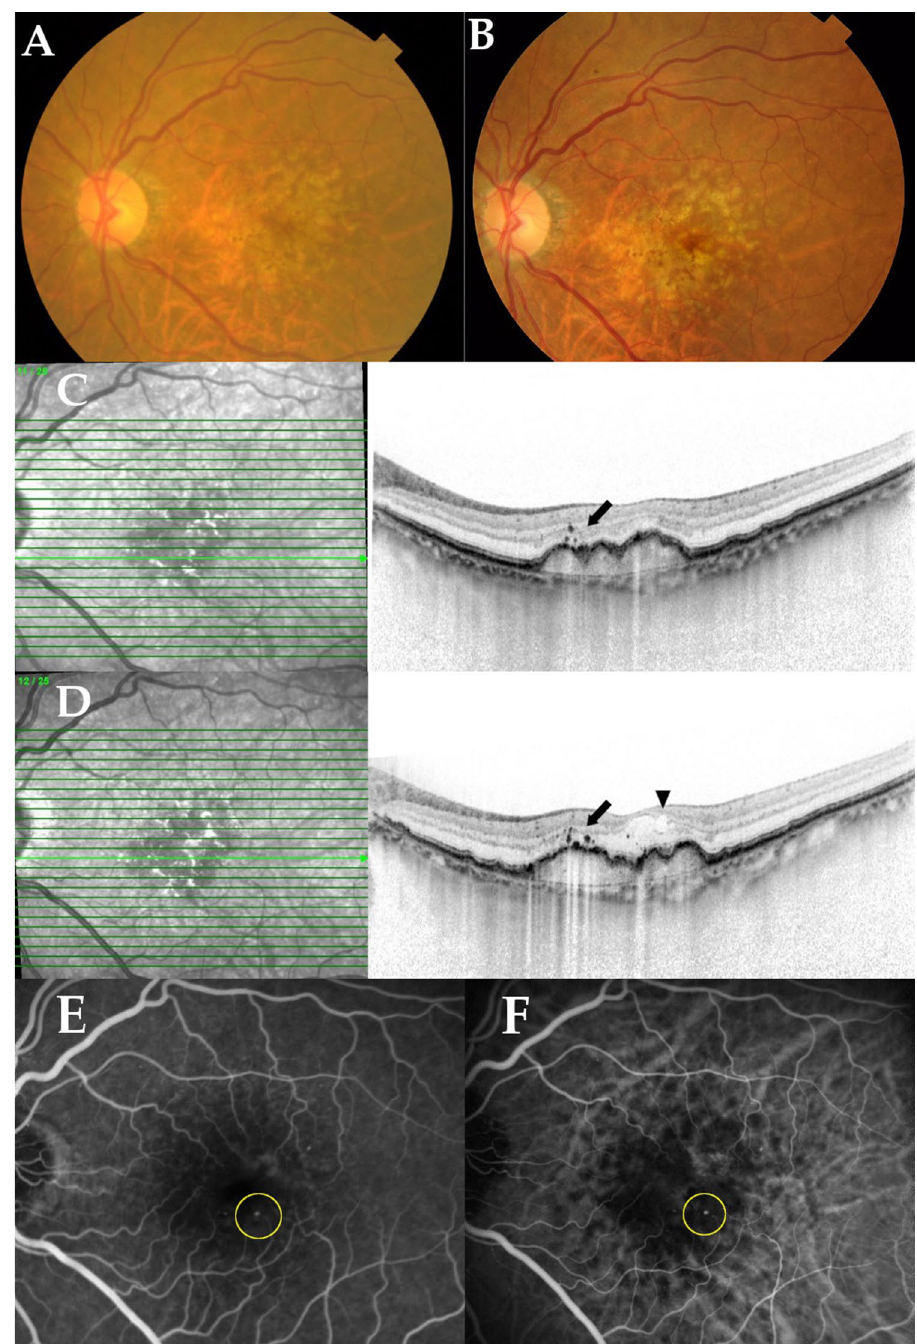
Figure 1. A representative case of a 71-year-old woman with intermediate age-related macular degeneration (AMD) colocalizing with hyperreflective foci (HRF) in the left eye and type-3 macular neovascularization (MNV) in right eye. ( A ) Color fundus photography of the left eye at the initial appearance demonstrates drusenoid pigment epithelial detachment (DPED) surrounded by reticular pseudodrusen in the macular area. ( B ) At 7 months after initial presentation, color fundus photography of the left eye demonstrates the development of intraretinal hemorrhage in the macular area. ( C ) A horizontal scan through the fovea by spectral-domain optical coherence tomography (SD-OCT) in the left eye at the initial appearance shows HRF (black arrow) near the protrusion of DPED. ( D ) A horizontal SD-OCT scan through the fovea of the left eye at 7 months shows the presence of intraretinal fluid (black arrowhead) and increased HRF (black arrow). ( E ) Fluorescein angiography and ( F ) indocyanine angiography of the left eye at 7 months shows a hot spot (yellow circle) that is consistent with type-3